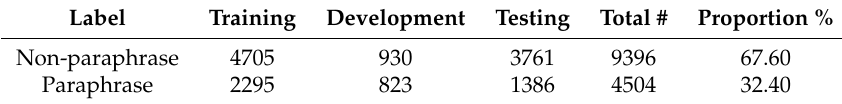
Table 5. ASSIN corpus plus the translated sentences of the MSRP